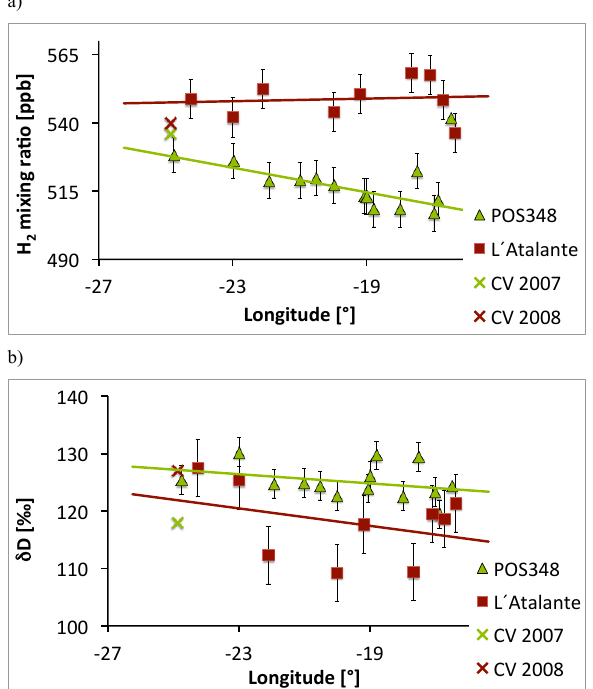
Fig. 2. H 2 mixing ratio (ppb) and δ D (‰) along the 18 ◦ N tran- 2 sect between the Cape Verde Islands and the West African coast in 2007 (green labeled) and 2008 (red labeled). The error bars in- dicate the average reproducibility. The crosses (CV 2007 and CV 2008) indicate the monthly measurement results from the Cape Verde observation tower (24 ◦ 87W, 16 ◦ 85N) closest to the sam- pling period (29 March 2007, and 8 February 2008). The Cape Verde measurements were part of the EUROHYDROS project (Batenburg et al., 2011). (a) H 2 mixing ratio (ppb): RV Posei- don (2007): − 2.25 x + 472, n = 13, r = 0.79; RV L’Atalante (2008): 0.24 x + 553, n = 9, r = 0.10. (b) Isotopic composition δ D (‰): RV Poseidon (2007): − 0.40 x + 117, n = 13, r = 0.31; RV L’Atalante (2008): − 0.76 x + 103, n = 9, r =−